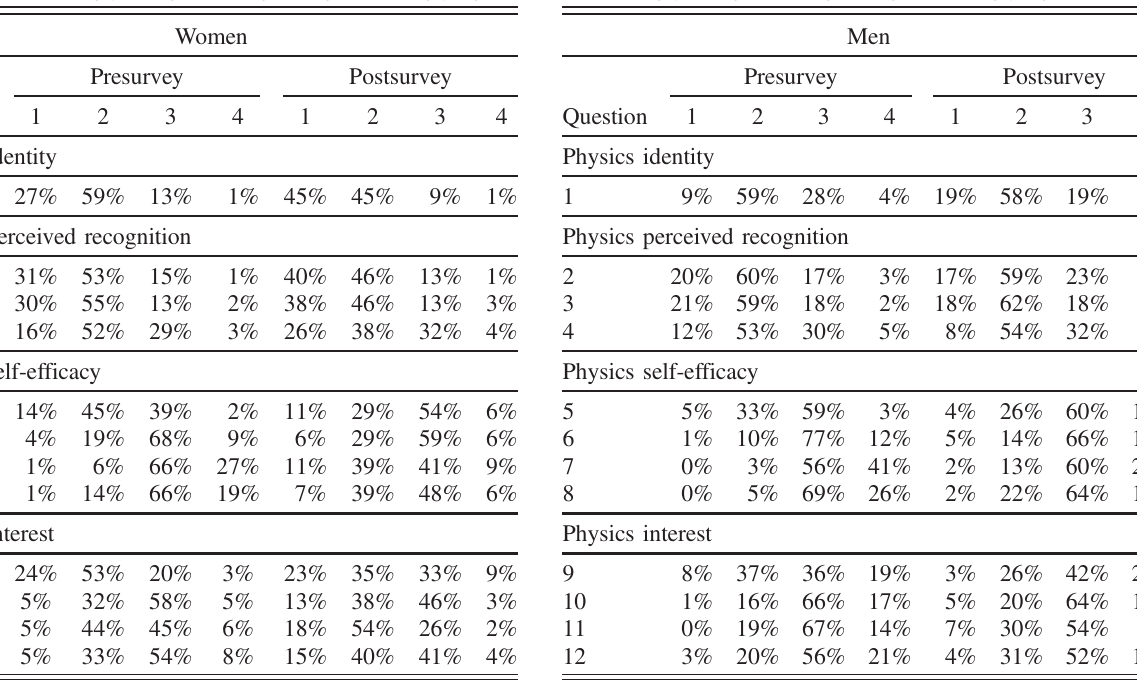
TABLE IX. Percentages of 126 men in physics 1 who answered each question by the options they selected with 1 being the low value (NO! and strongly disagree) and 4 being the high values (YES! and strongly agree). The rating scale for the self-efficacy and interest questions was NO!, no, yes, YES! while the rating scale for the physics identity and perceived recognition questions was strongly disagree, disagree, agree, strongly